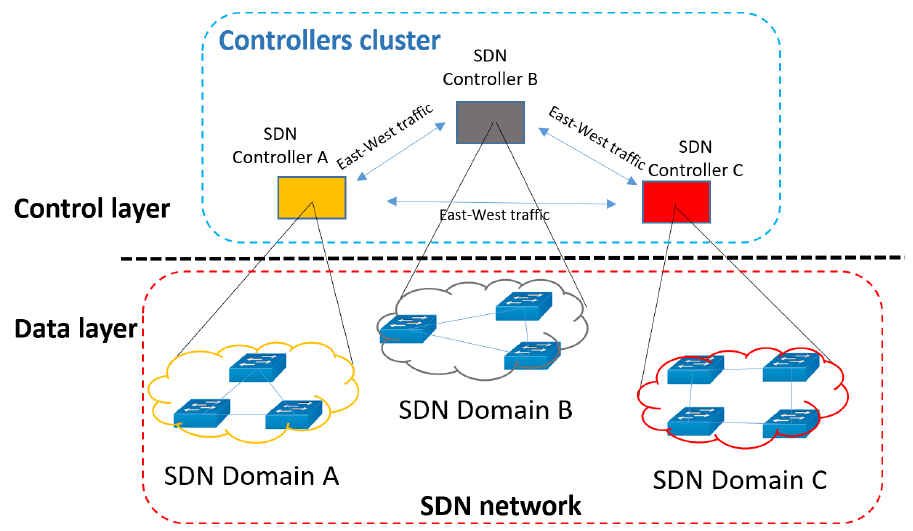
Figure 1. Distributed SDN